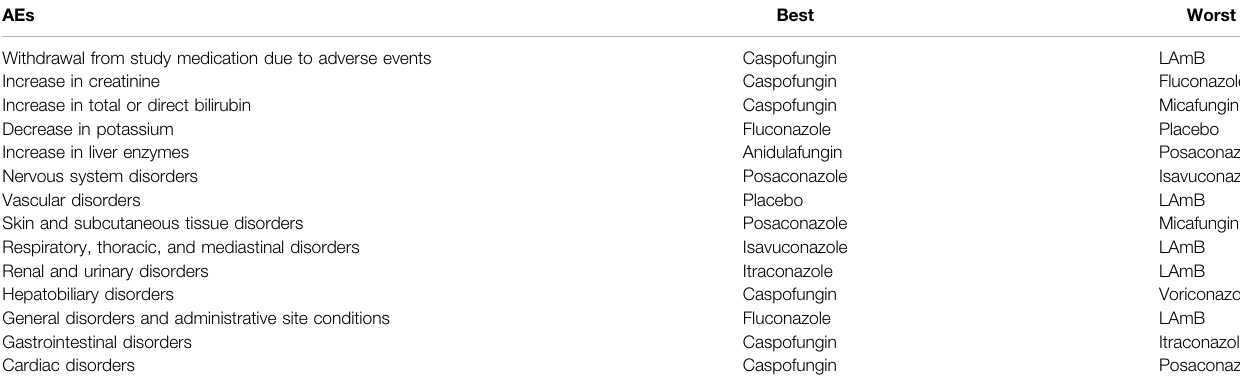
Table S2.32 . Among the SUCRA rankings, caspofungin was the best and itraconazole was the worst Table 2 .